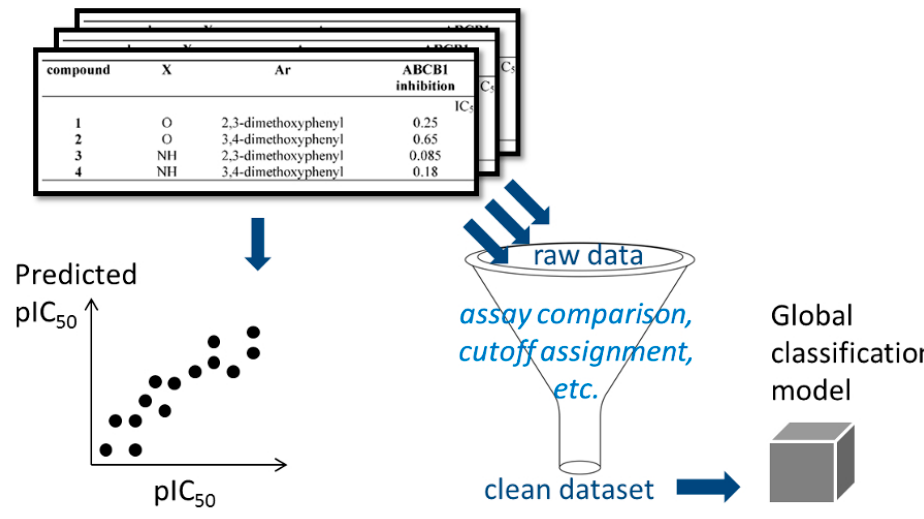
Figure 1. Schematic depiction of data compilation and modeling workflow.